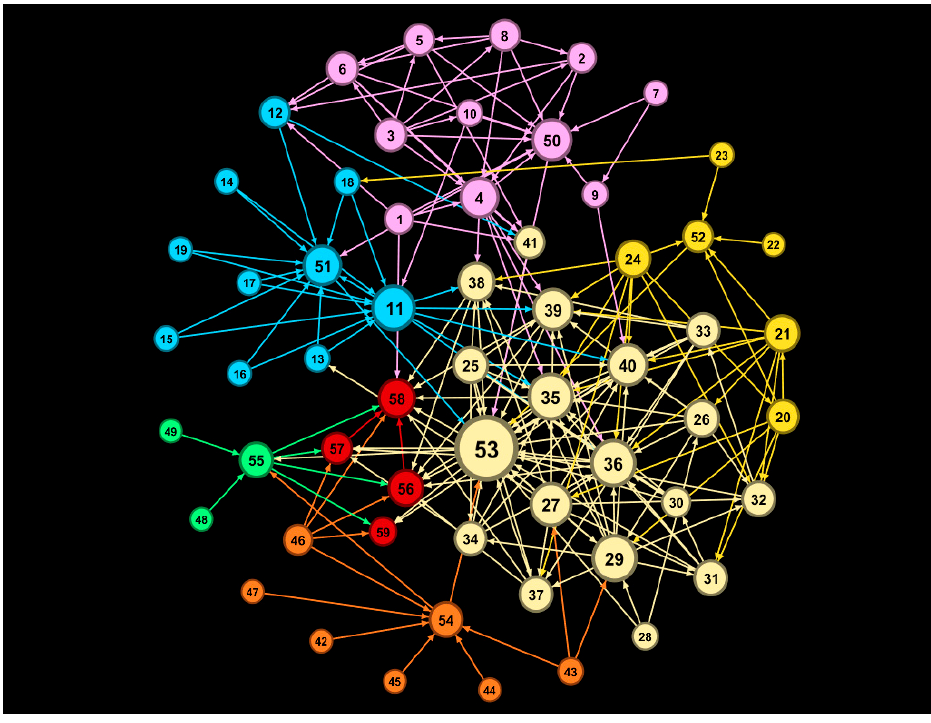
Figure 3. Network model of quality control factors of prefabricated buildings.